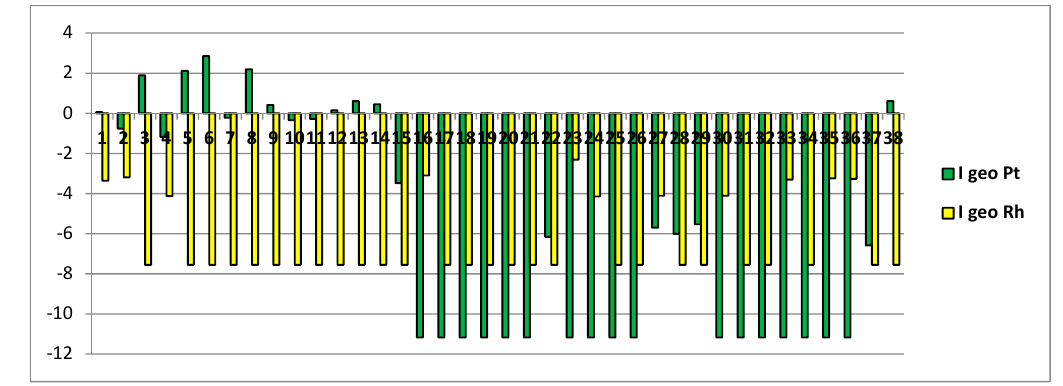
Figure 4. Geoaccumulation index